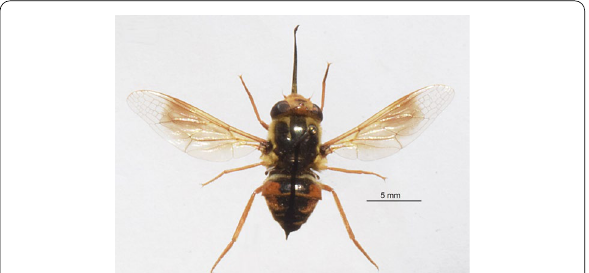
Fig. 3 Nemestrinus rufipes (Olivier) female habitus, dorsal